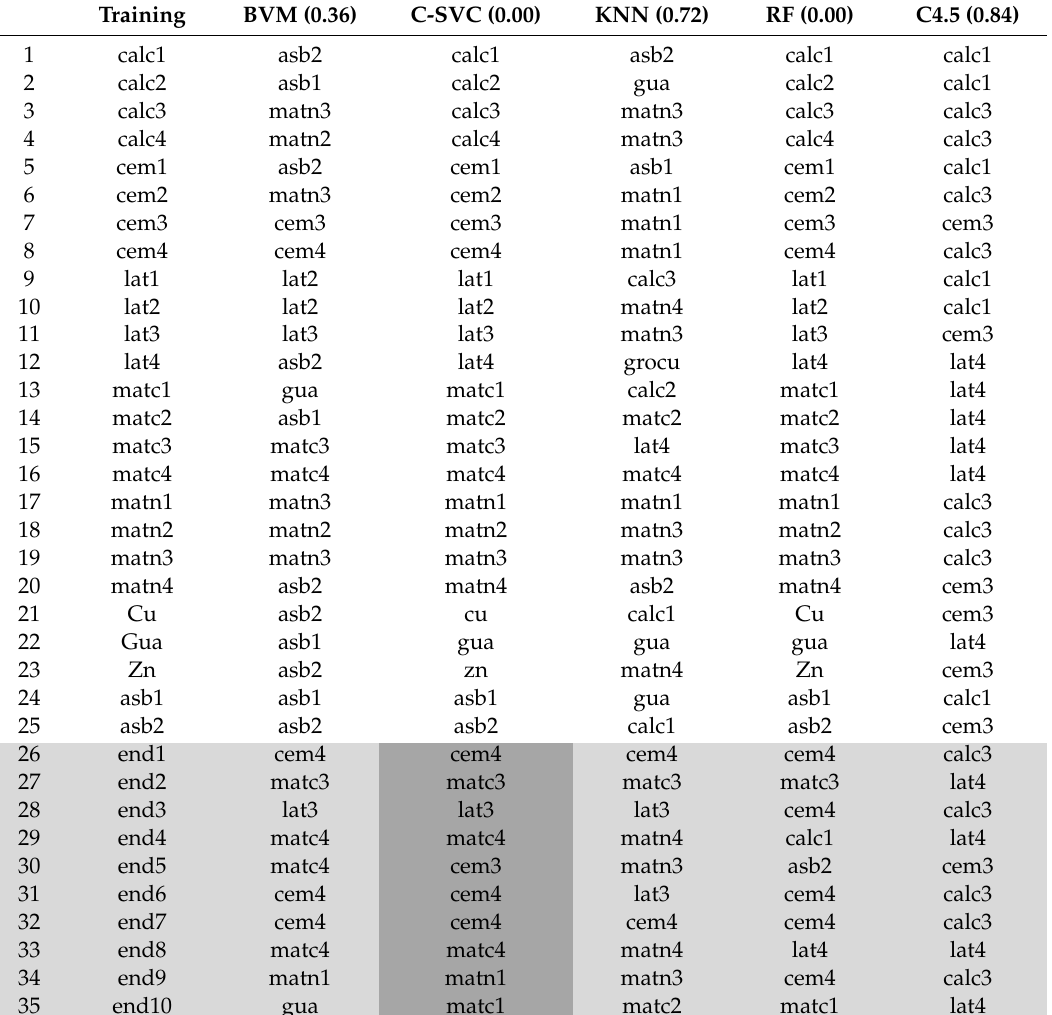
Table 3. The results obtained with di ff erent machine learning algorithms for endmember-supervised classification to assign the rubble typology labels to them, are reported in the last 10 rows of table (in light grey and darker grey for C-SVC, exploited in the subsequent steps). The first 25 rows show the training results for the di ff erent machine learning algorithms tested: BVM, C-SVC, KNN, RF, C4.5. The error rate in training was reported under the column label indicating the